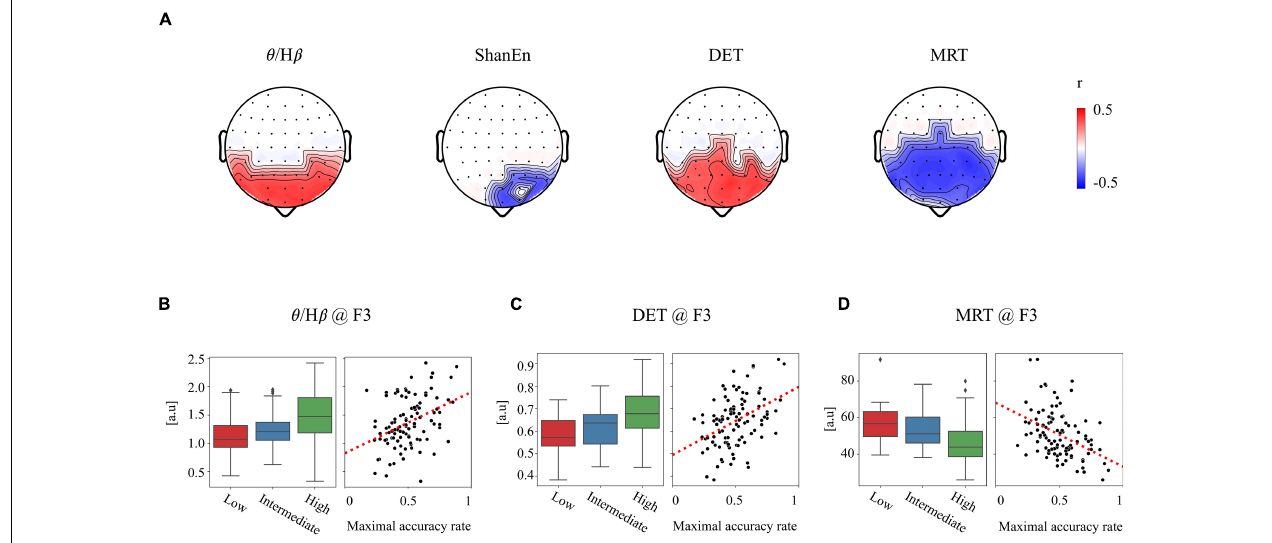
FIGURE 2 | Significant relationship between the prior EEG features and subsequent BCI performance. (A) Four exemplar topographies for significant EEG features in the REO condition with significant statistical results ( p < 0.01 and | r | > 0.3). (B–D) Three exemplar EEG features at the F3 site corresponding to (B) θ / H β , (C) DET, and (D) MRT. Boxplots of each feature corresponding to three BCI groups (left) and scatterplots of each feature corresponding to the BCI performance